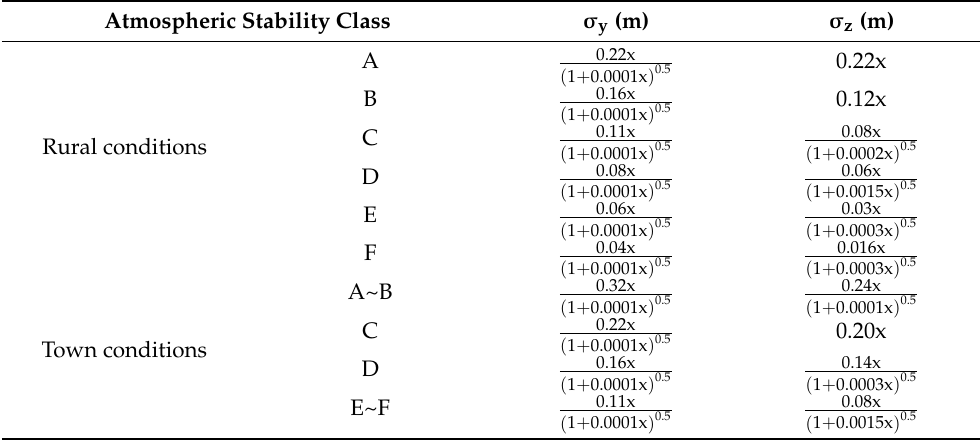
Table 3. Diffusion coefficient of the Gaussian plume model.